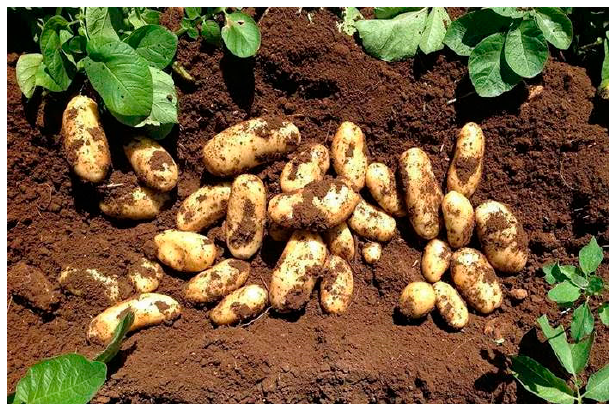
Figure 2. Selenium